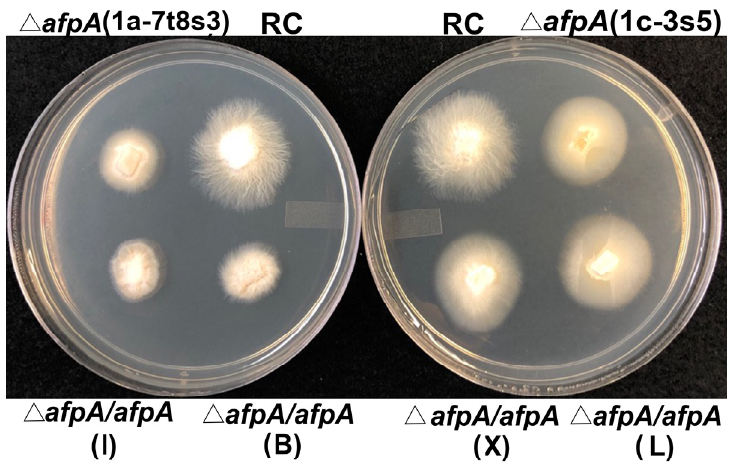
Figure 2. Comparison of colony morphology of the wild type E. festucae Rose City (RC) isolate, the two knockout isolates, and the four independent complemented knockout isolates on potato dex- trose agar plates. The letter designations of the four complemented knockout isolates (I, B, X, and L) are given in parentheses.